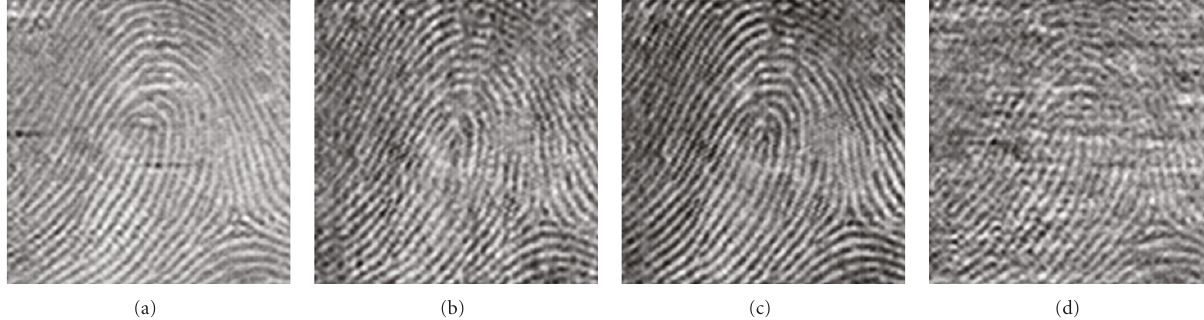
Figure 14: Recovered watermarks from Lena image after applying di ff erent noises (a) Salt and pepper (density = 0 . 0001) (b) Gaussian noise (density = 0 . 0001) (c) Speckle noise (density = 0 . 0001) (d) Poisson noise.